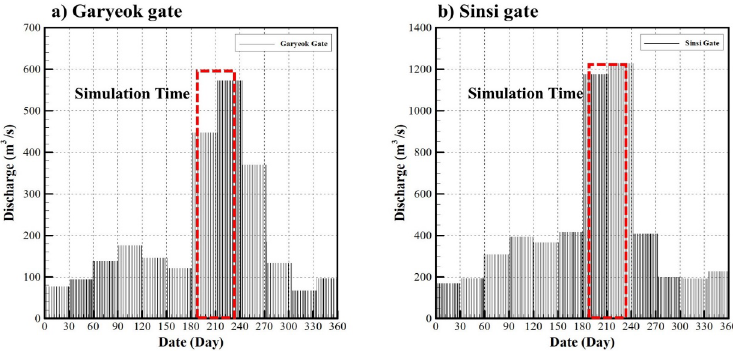
Figure 4. a) The operation of Garyeok gate, b) The operation of Sinsi